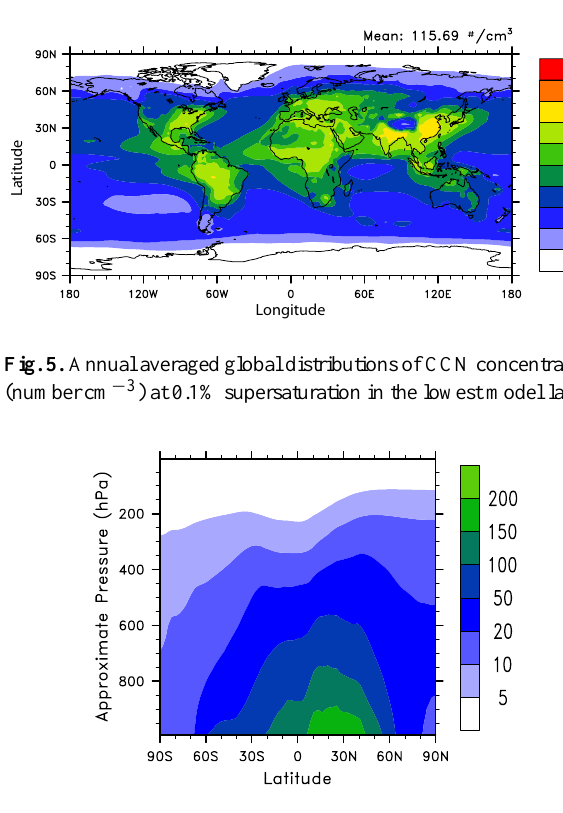
Figure 06 Fig. 6. Zonal mean CCN concentrations (numbercm